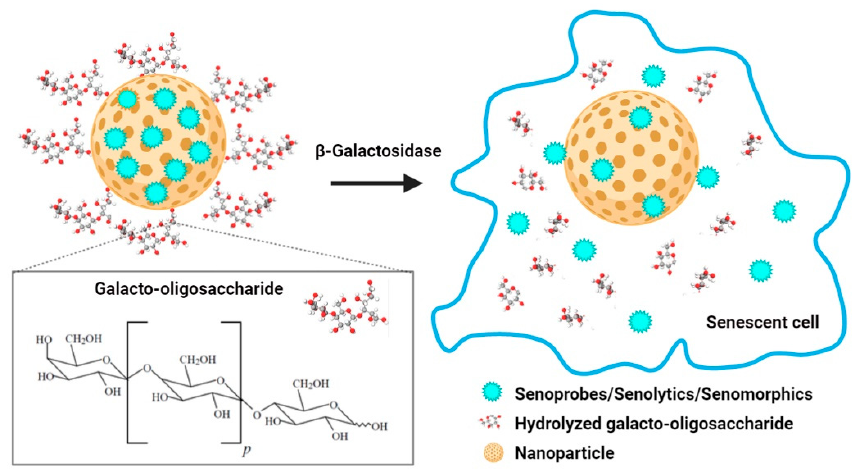
Figure 3. Nanoparticles capped with galacto-oligosaccharide and loaded with senoprobes, senolytics, and / or senomorphics. Cargos can be preferentially released and activated in senescent cells with high activity of SA- β -galactosidase that is based on SA- β -galactosidase-mediated hydrolysis of an oligosaccharide coat.